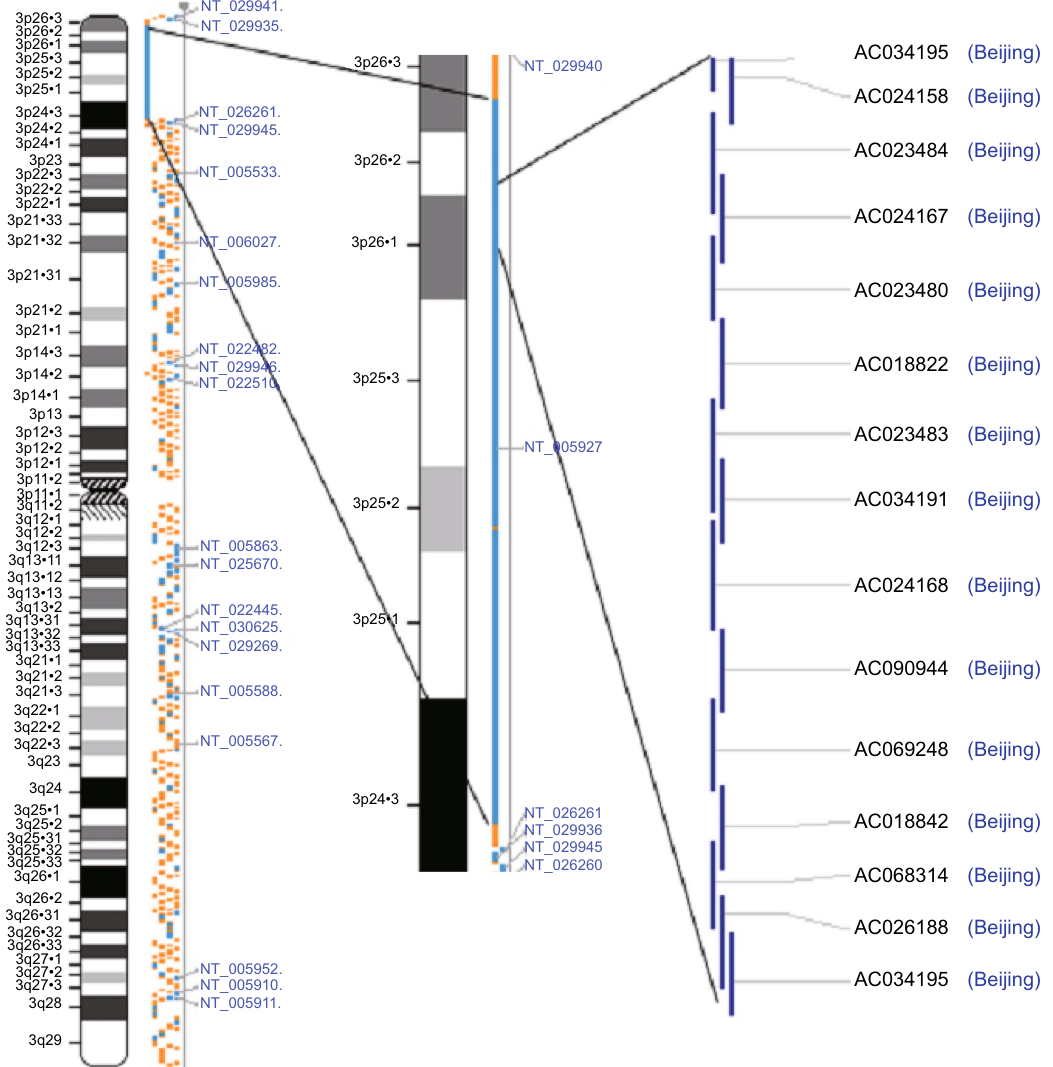
Figure 4. The “ Beijing Region ” of the fi ne map of the human genome